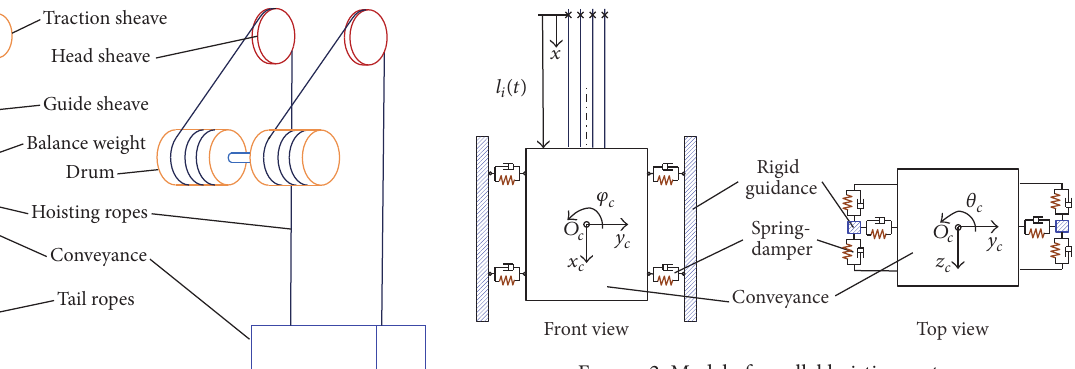
Figure 2: Model of parallel hoisting